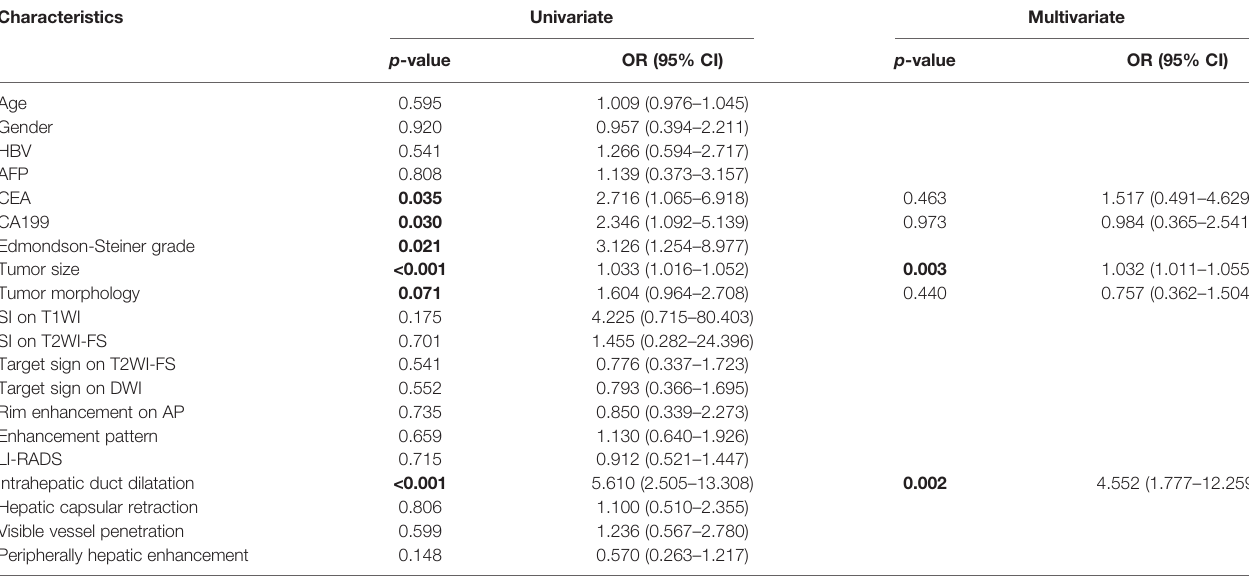
TABLE 2 | Univariate and multivariate analyses of predictive characteristics related with MVI status in ICC.